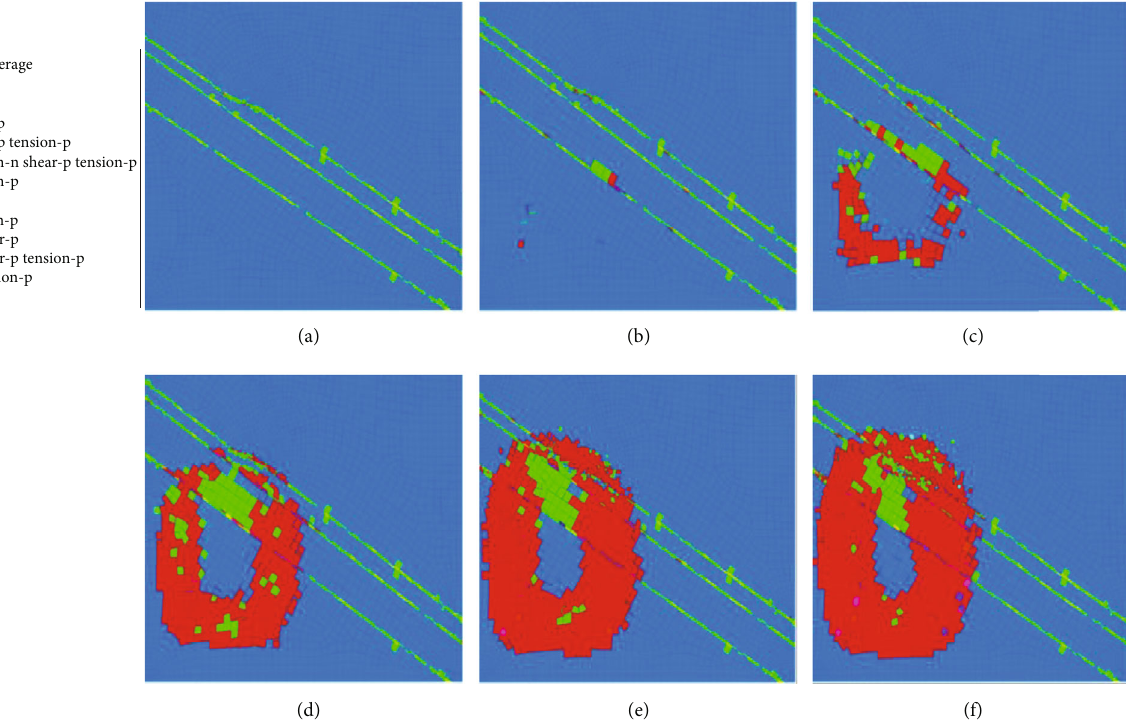
Figure 10: The roof plastic zone of 3 coal roadway during the advancing period of 97308 working face. (a) Working face advancing 120 m; (b) working face advancing 160m; (c) working face advancing 200 m; (d) working face advancing 240 m; (e) working face advancing 280 m; (f) working face advance over